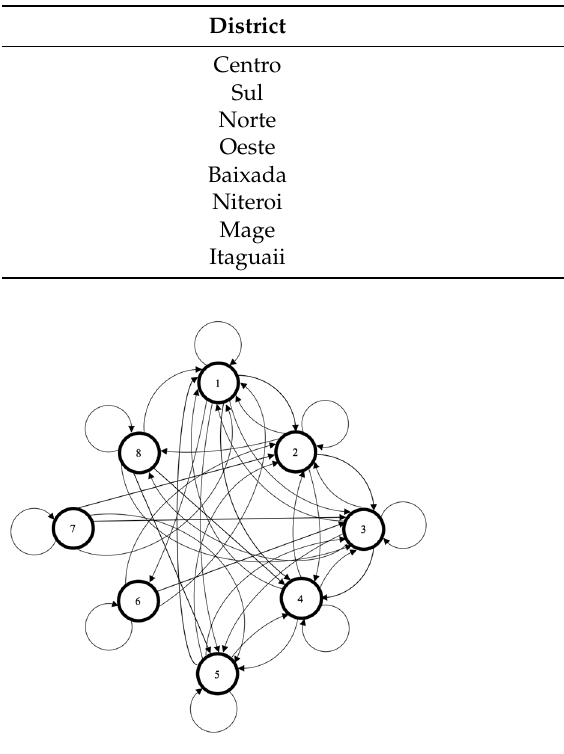
Figure 9. The MACS graph of human movements within the 8 macro-districts. The obtained adjacency matrix of the graph is determined.